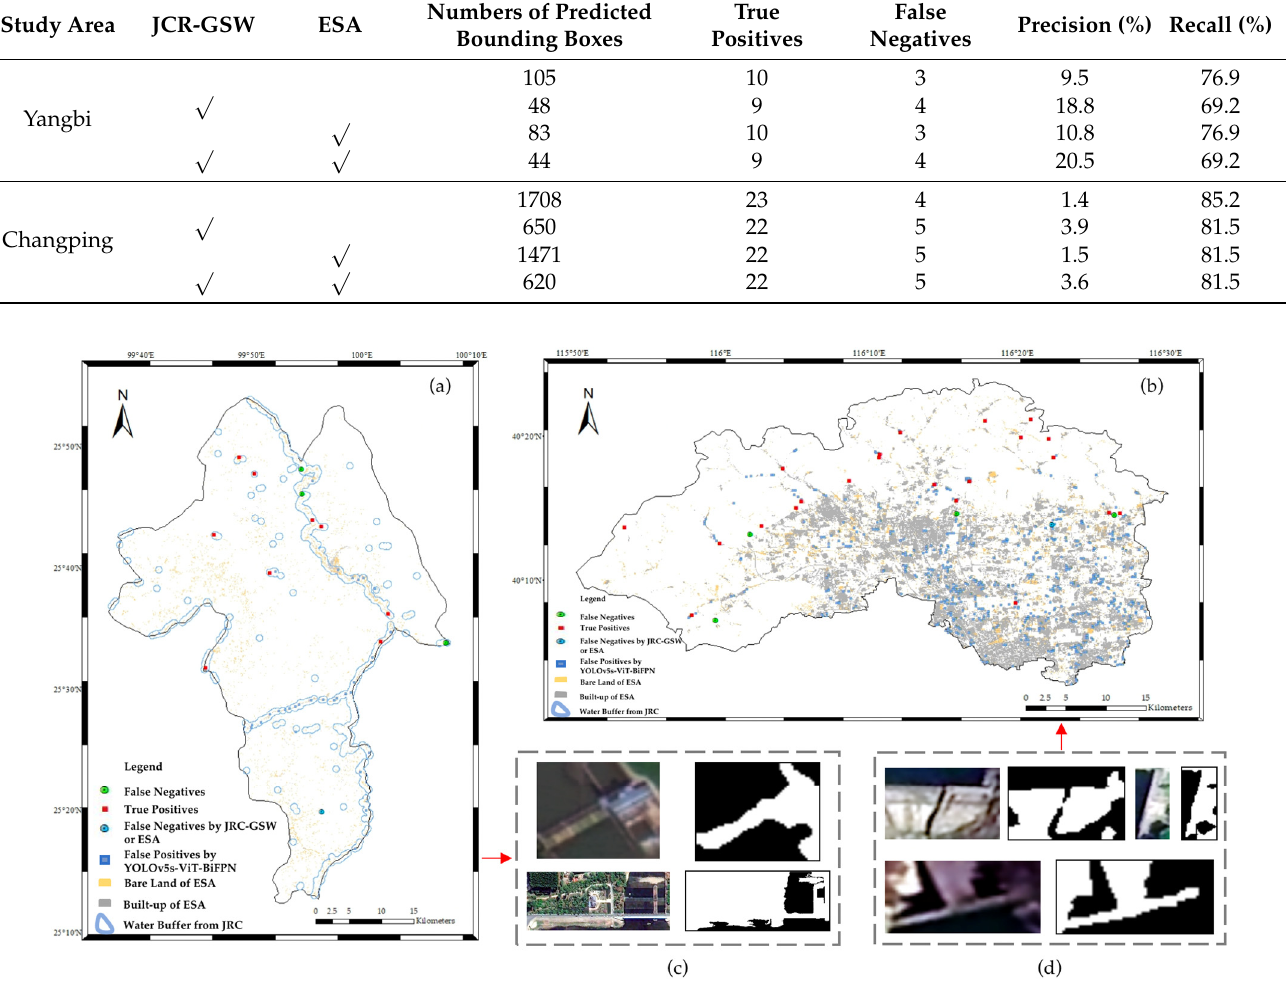
Figure 15. Results of dam extraction in the two study areas. ( a ) The results of dam extraction in Yangbi. ( b ) The results of dam extraction in Changping. ( c ) Examples of dam segmentation in Yangbi. ( d ) Examples of dam segmentation in Changping.